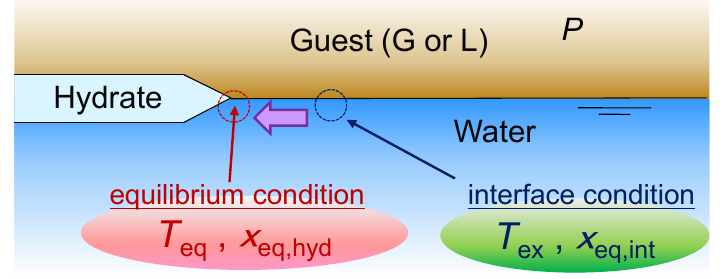
Figure 2. Illustration of hydrate-layer growth at the guest/liquid-water